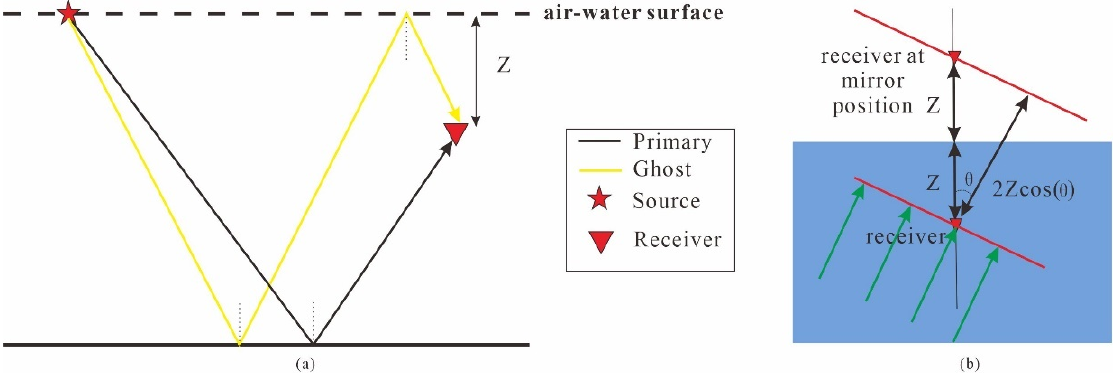
Figure 1. Schematic illustration of ghost propagation. ( a ) The propagation of ghost. ( b ) The estimation of ghost delay time.